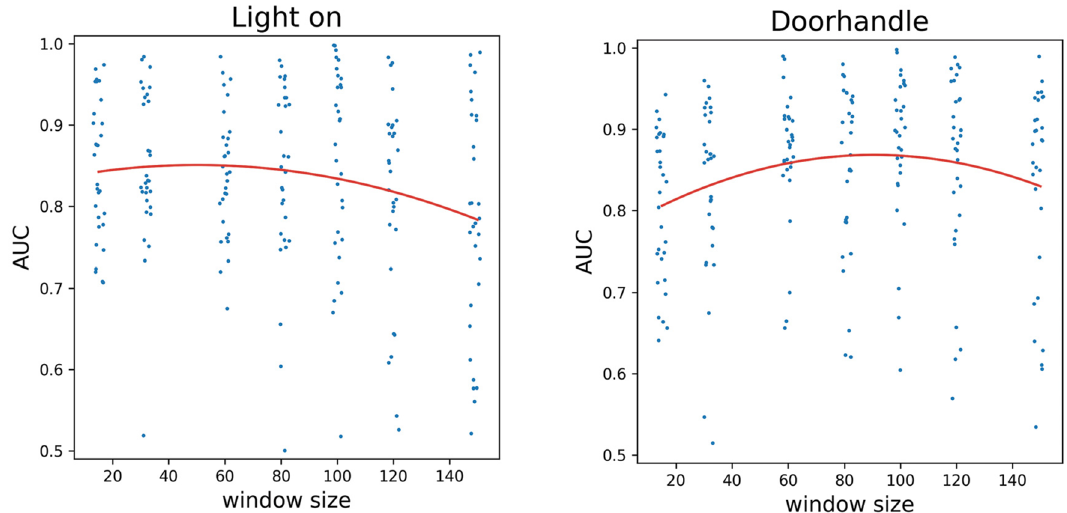
Figure 4. The AUC values of two everyday activities as a function of the window sizes and the quadratic curves fitted (Light on: adj. R 2 = 0.138, Doorhandle: adj. R 2 = 0.088) for the two activities with the highest R 2 . A small random jitter was added to the window sizes for better visibility.